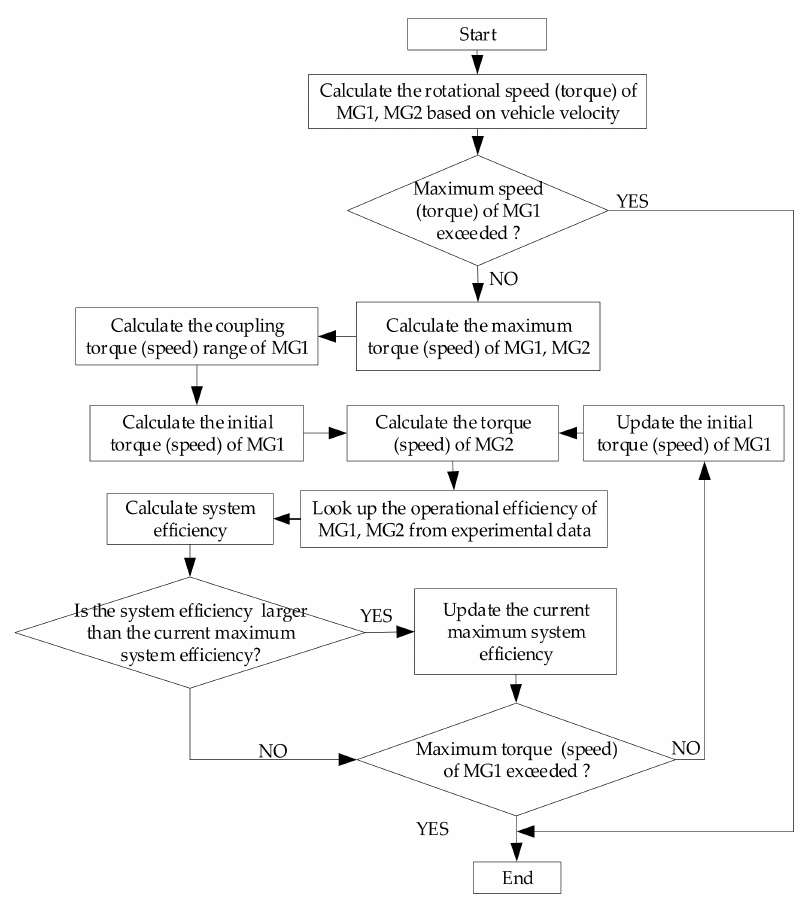
Figure 2. Flowchart for power distribution in two motors torque coupling drive (M3) (two motors speed coupling drive